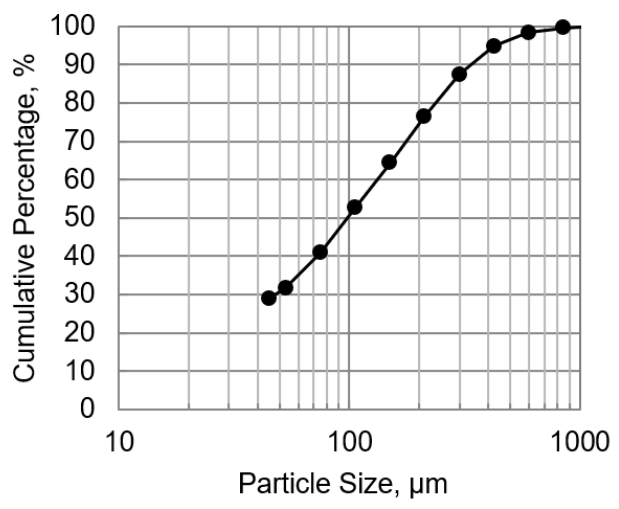
Figure A1. Typical particle size distribution in the flotation feed to the rougher banks A and B.